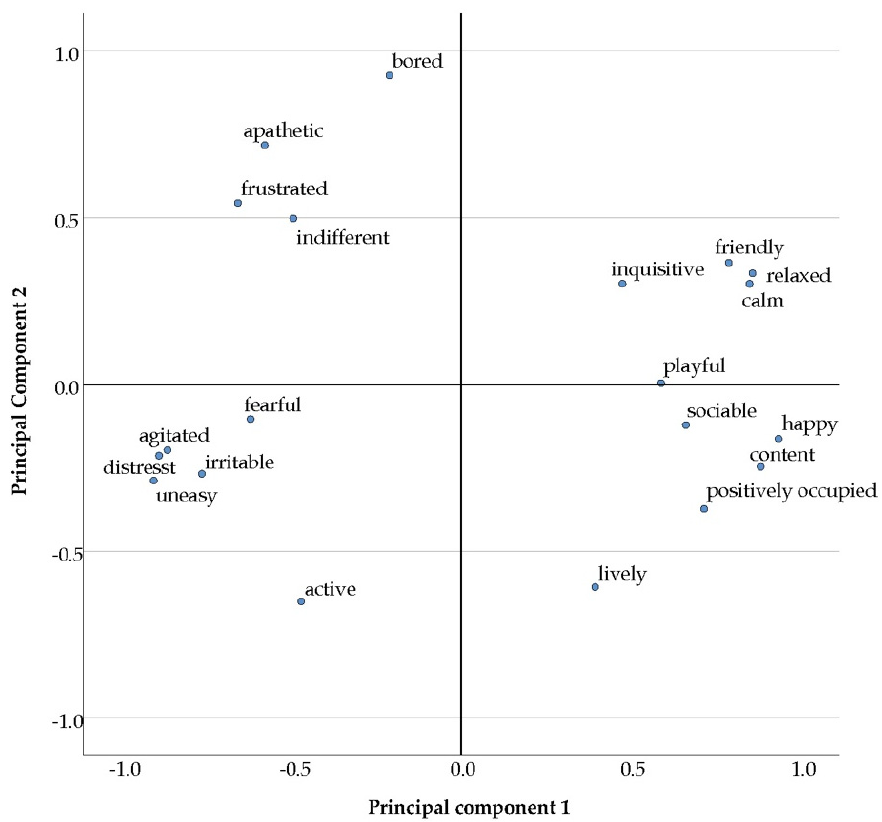
Figure 1. Principal component plot, showing the loadings of the 20 QBA descriptors on the first and second principal component, extracted based on a correlation matrix, without rotation ( n = 25).